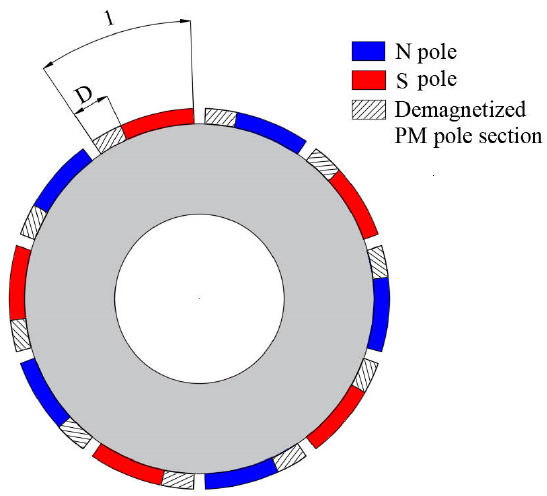
Figure 2. Model of magnets with uniform demagnetization.